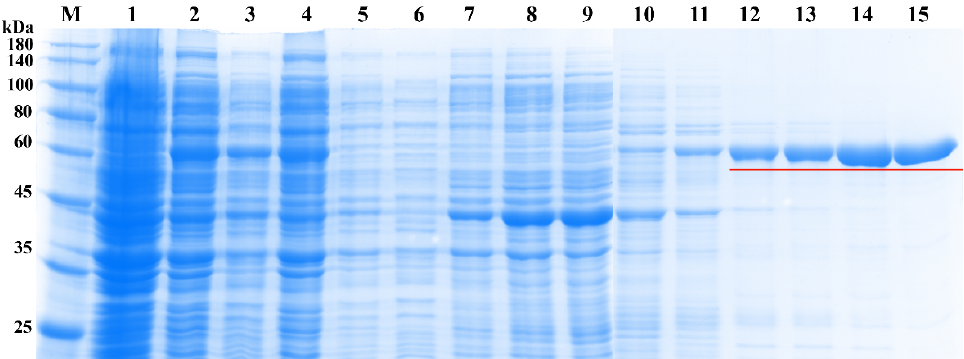
Figure 8. SDS-PAGE determination of purified prokaryotic expression protein pET28a- UGT84A77 . M, protein marker; lane 1 indicates protein expression not induced by IPTG; lane 2 indicates total protein induced by IPTG; lane 3 indicates total soluble protein in supernatant; lane 4 indicates insoluble protein in pellet; lane 5 indicates effluent after flowing through resin; lane 6 indicates washing buffer after flowing through resin; lanes 7–15 indicate the proteins eluted by 40, 60, 80, 100, 120, 140, 160, 180, and 200 mM imidazole eluents, respectively; the underline indicates the purified objective protein of pET28a- UGT84A77 .